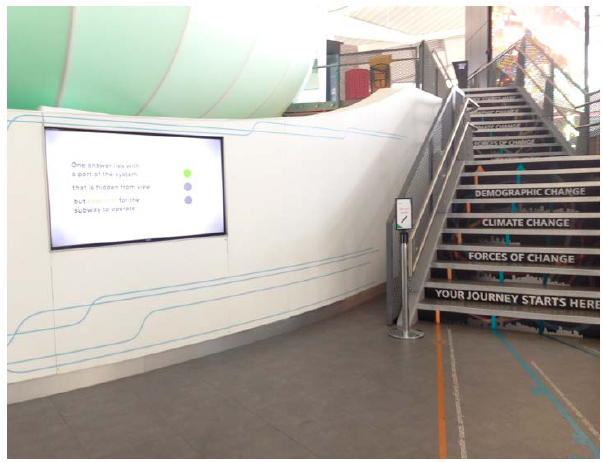
Photograph taken at the entrance of The Crystal exhibition (Source: author, 2021).